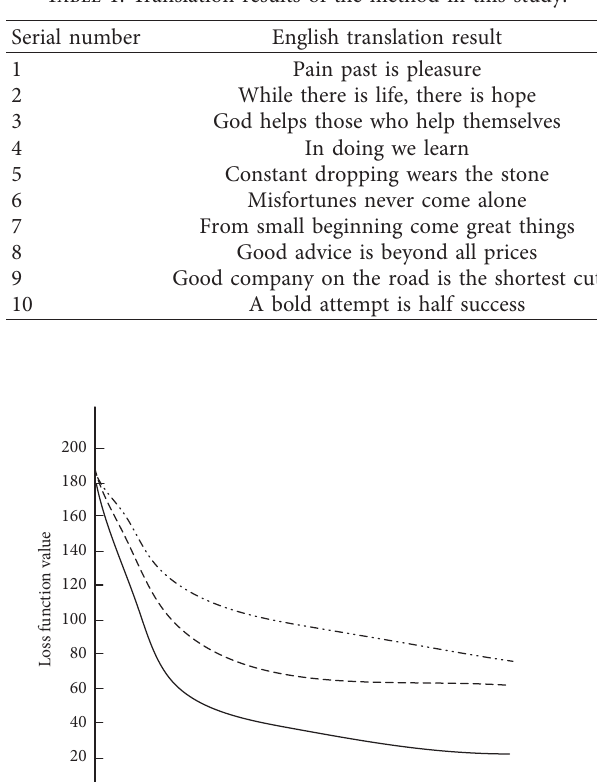
Table 1: Translation results of the method in this study.